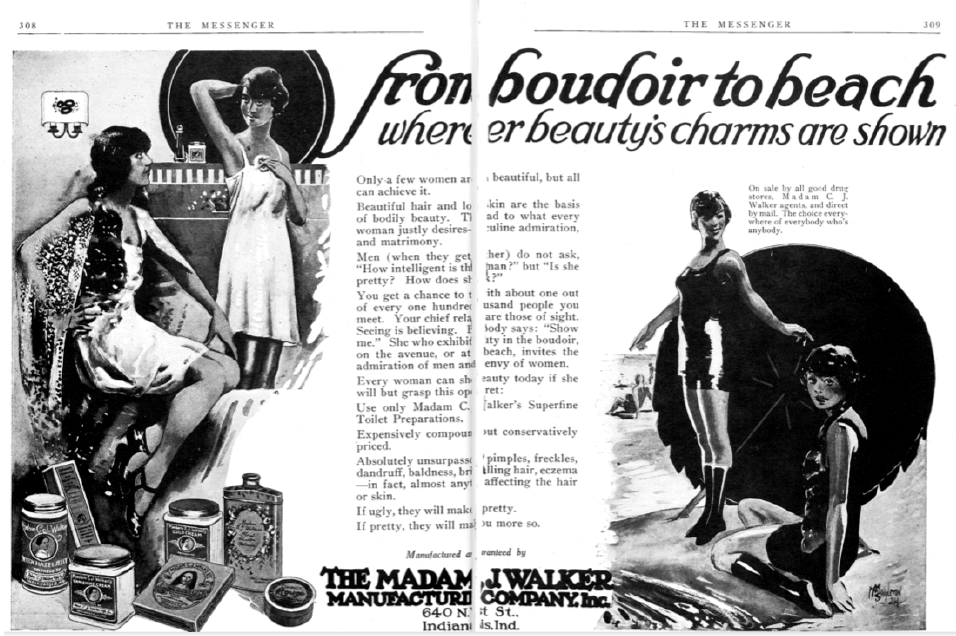
Figure 2. “From Boudoir to Beach”, The Messenger , October 1924, pp. 308–9.